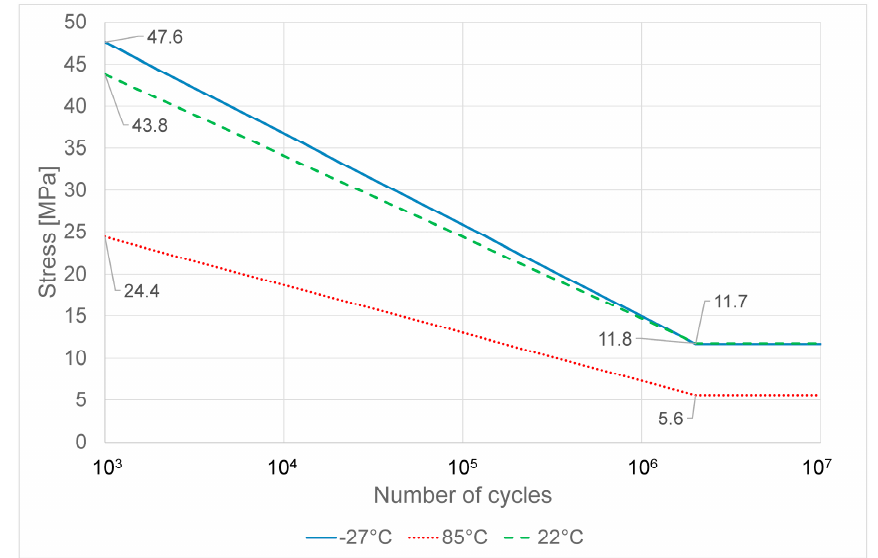
Figure 8. Wöhler curve at 50% survival for ABS at different temperatures.